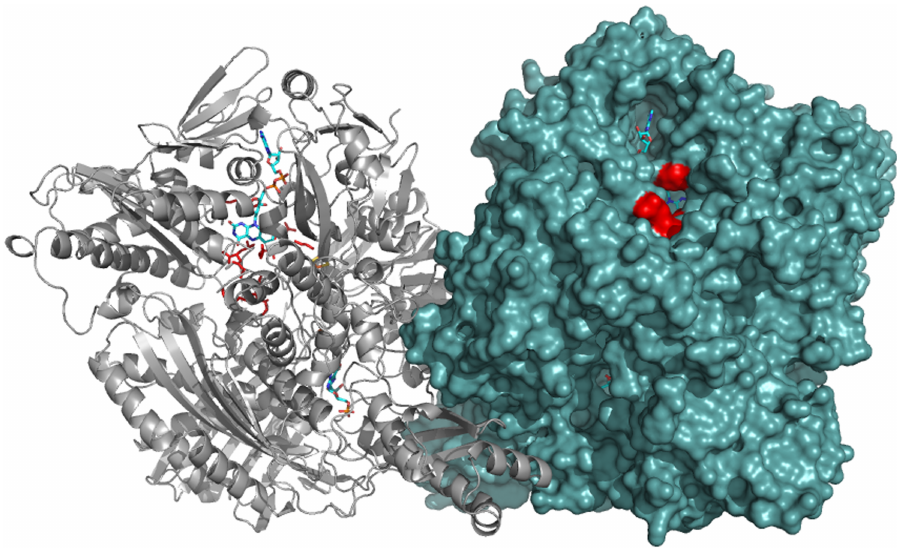
Fig 1. Overall structure of the hAOX1 dimer and location of the SNP-based amino acid exchanges. MonomerA is shown as surface representation (right) and the monomerB as cartoon (left) showing the